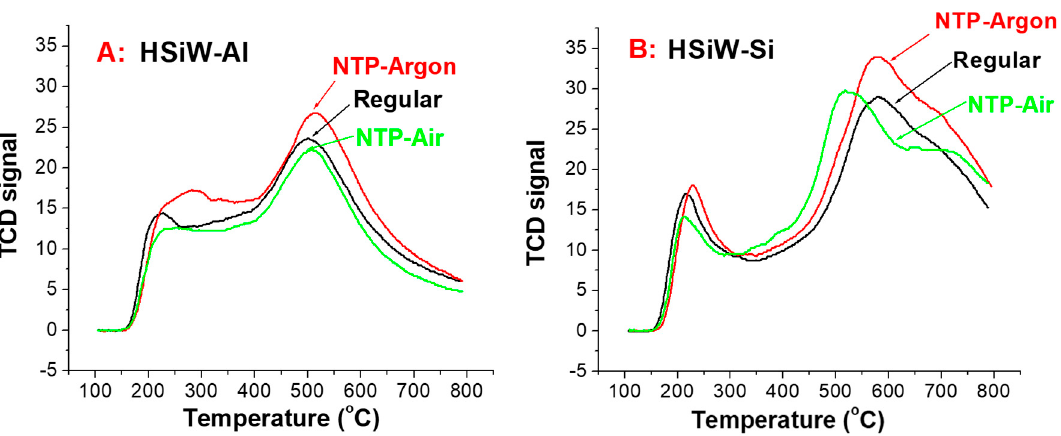
Figure 2. TPD-NH 3 desorption profile of ( A ) HSiW-Al and ( B )